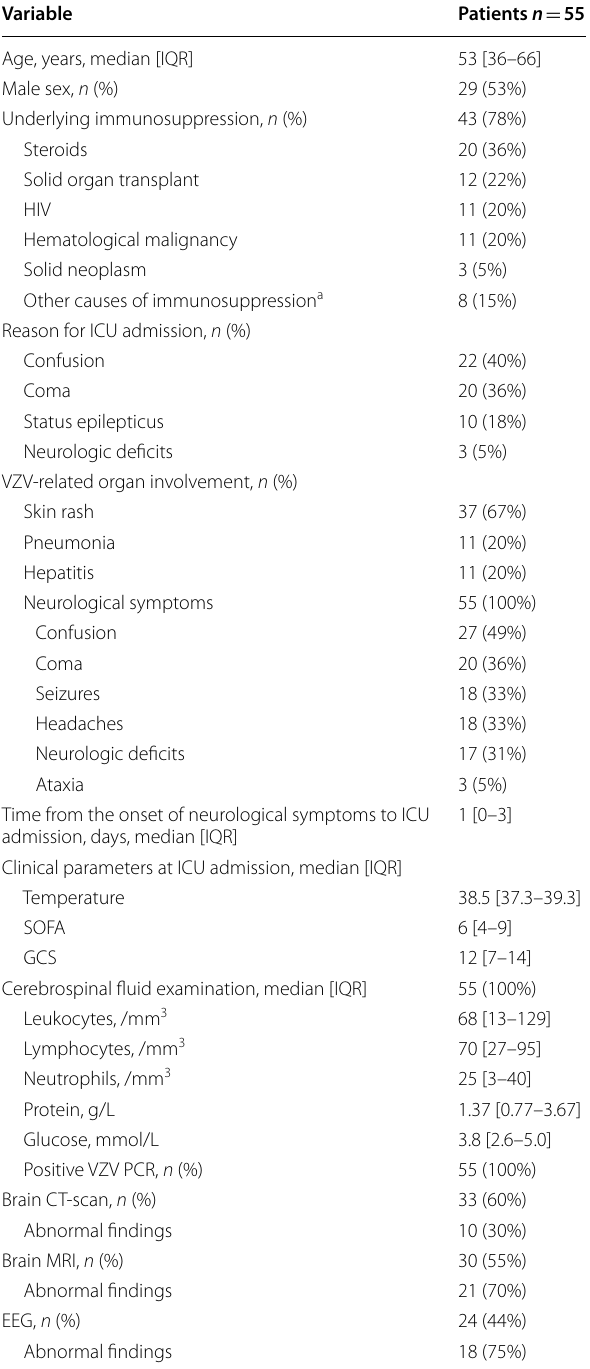
Table 1 Baseline characteristics of the 55 study